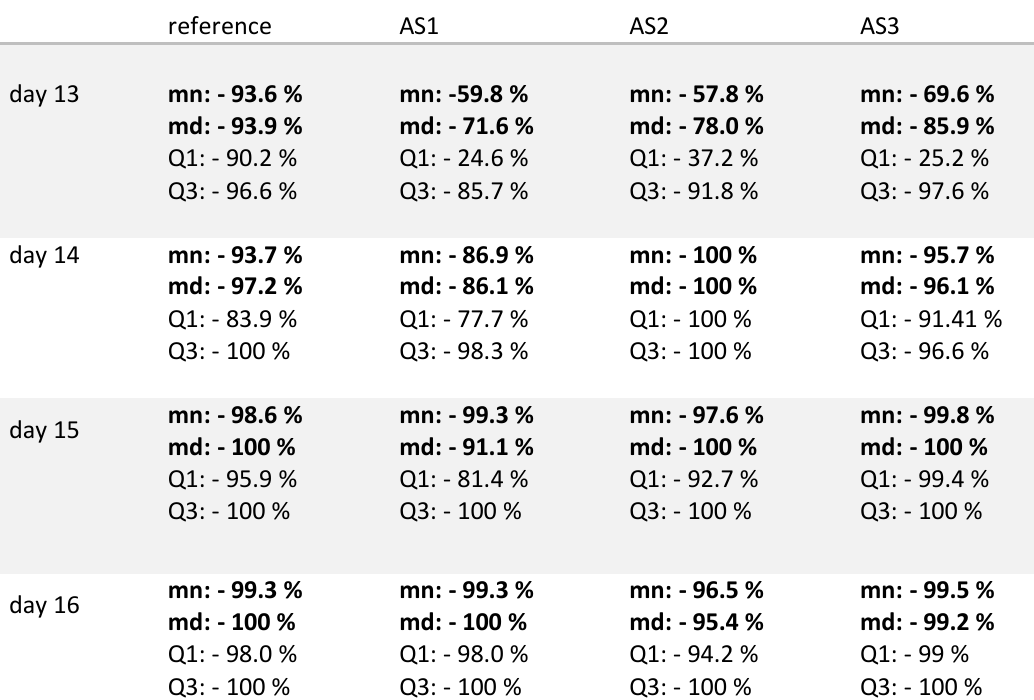
ST3: Reduction in parasitaemia as a result of the AS treatment for each of the 3 lines. Treatment was given on days 12-15, parasitaemia was calculated 24h after each treatment (days 13-16). The reduction in parasitaemia is calculated as (px-pb)/pb * 100 where px = parasitaemia at a given day, and pb = baseline parasitaemia (parasitaemia immediately before the treatment, day 12). mn=mean, md=median, Q1=25%